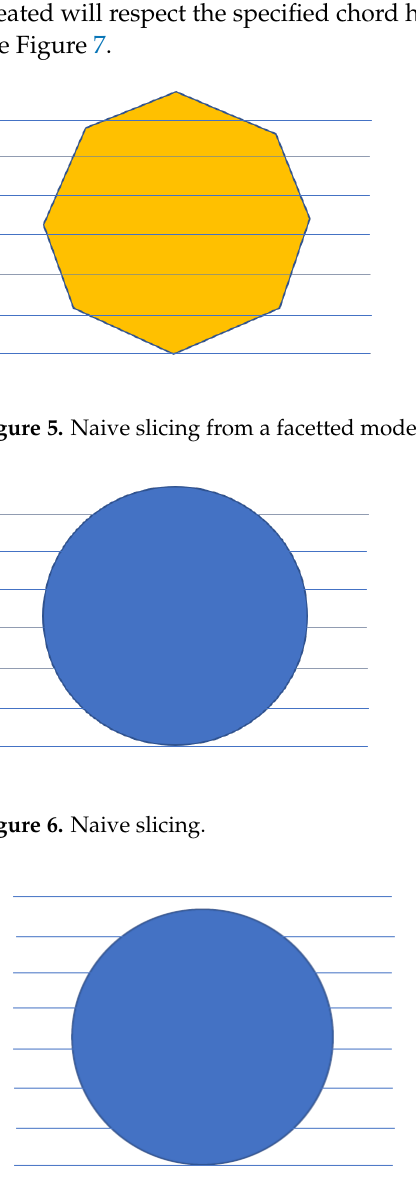
Figure 7. Exact slicing with thick